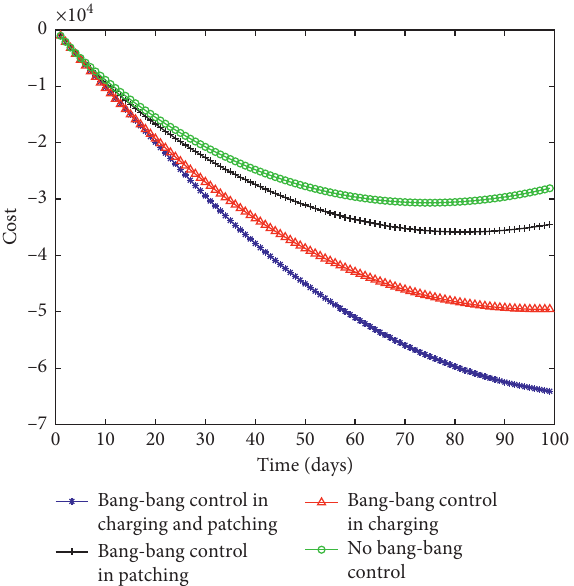
Figure 8: Cost comparison based on four control combinations. The four combinations are consistent with the four in Figure 7. The advantages of the combinations are further explained by comparing the costs incurred by